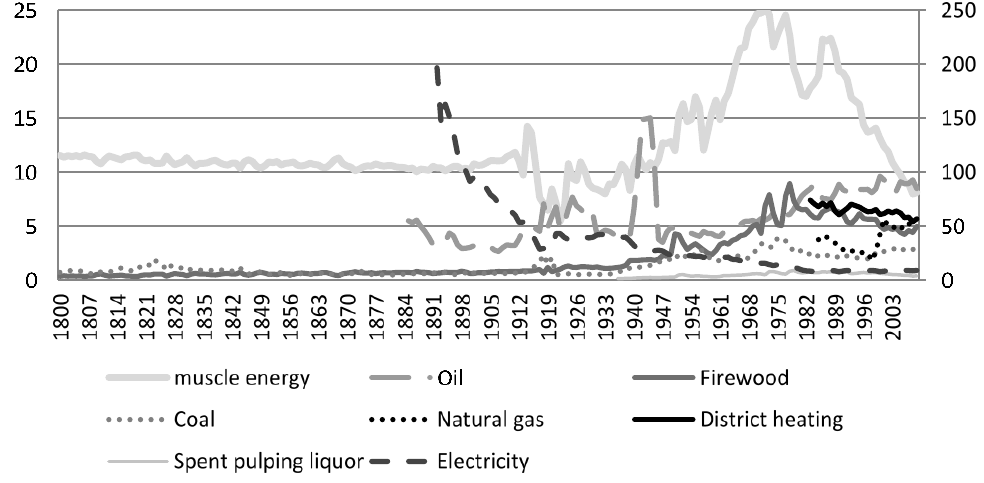
Figure 14. Development of prices in Sweden (mlnSEK/PJ, constant prices with the price level 1900), electricity price on the right axis. Note: “District heating is a system of centralised heat production and distribution typically employed in urban areas. The systems usually consist of heat plants (often producing heat and electricity simultaneously) and a network of distribution and return pipes” [69]. In the case of Sweden it often includes spill energy from industrial